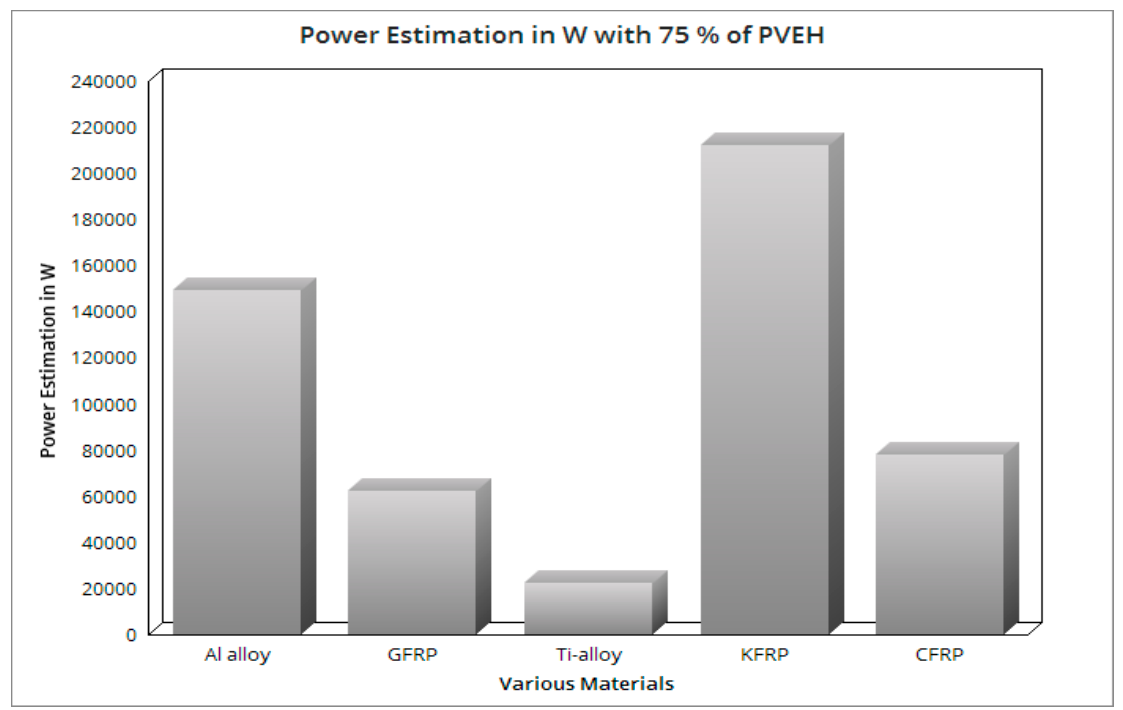
Figure 35. Power (P 0 ) in W with 100% attachment coverage—wind turbine blade.